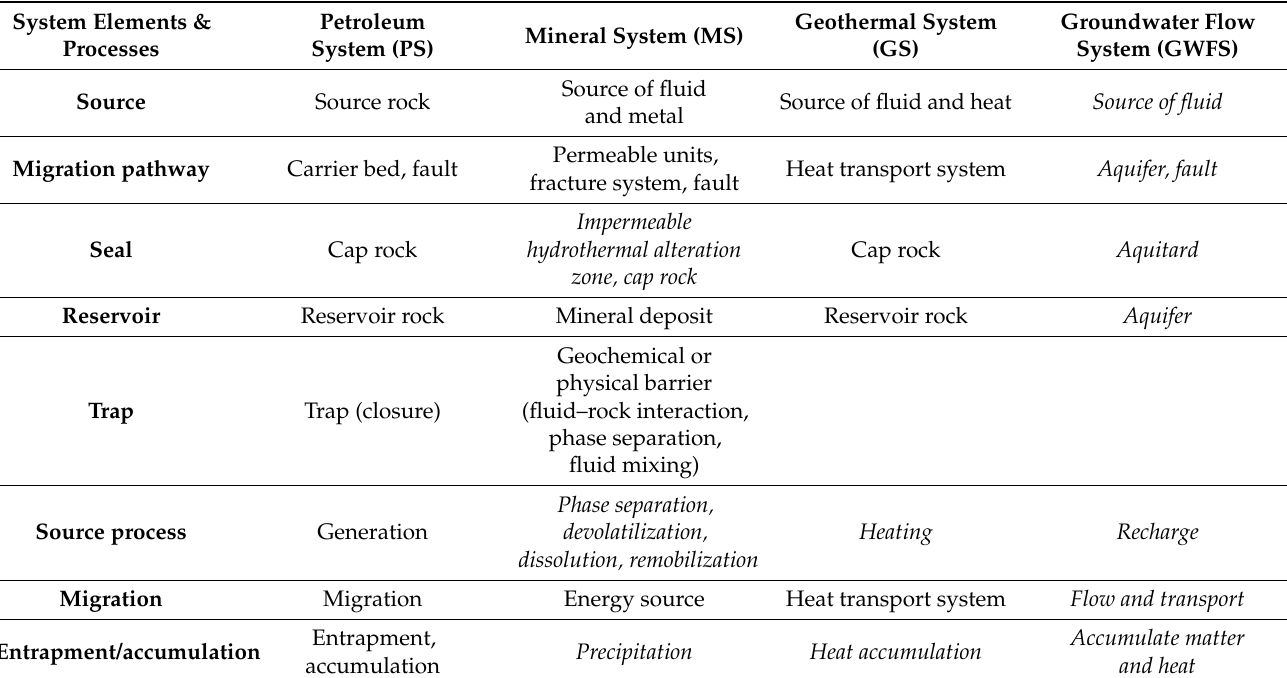
Table 1. Comparison of the simplified elements and processes of petroleum, mineral and geothermal systems. Processes being not named in the original definitions are signed by italics. Groundwater flow systems can also be classified